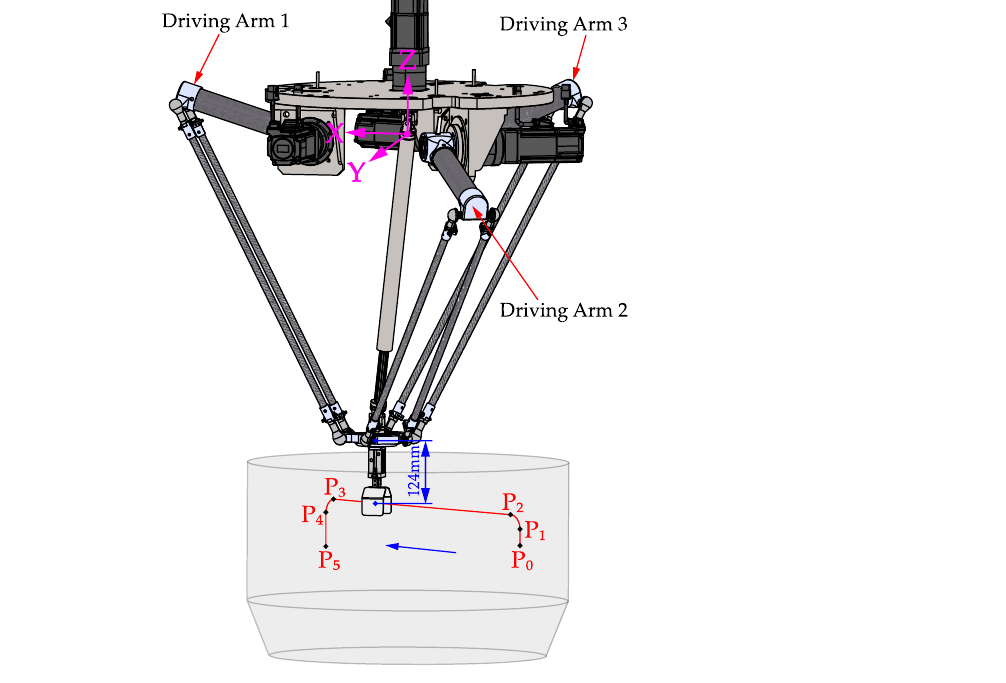
Figure 3. Trajectory of the Delta robot. Table 3. Position